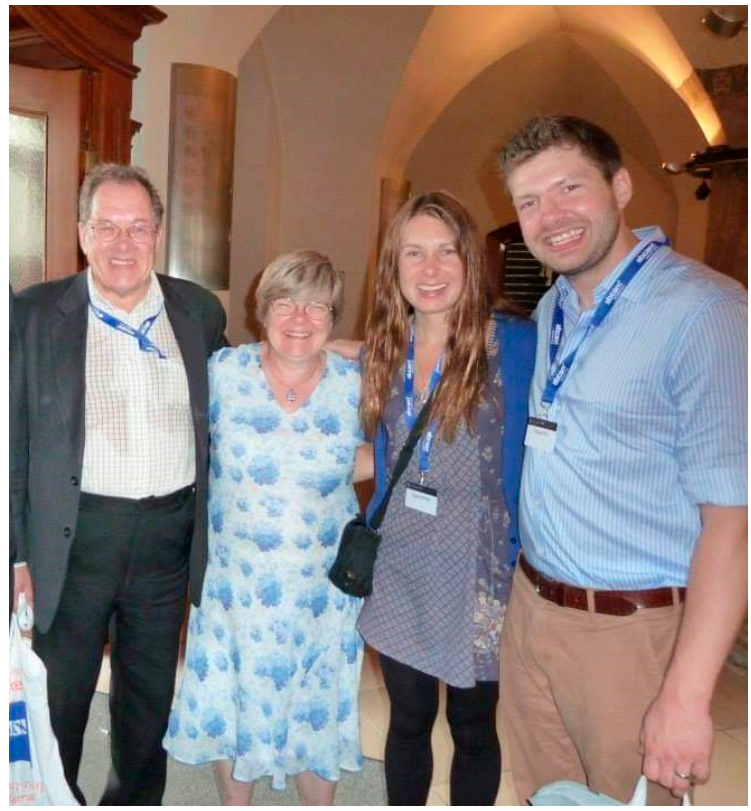
Figure 3. Bob’s outstanding contributions to the complement research field were recognized in 2013, when he received a lifetime achievement award from the European Complement Network (ECN). Bob was a devoted family man. He leaves behind Edith (his wife of over 45 years), two children (Francis and Grace), and four grandchildren (Charles, Stanley and Wilfred Sim, and Mary Mackintosh). From left: Bob, Edith, Grace and Francis at Jena, Germany, after the ECN award ceremony.